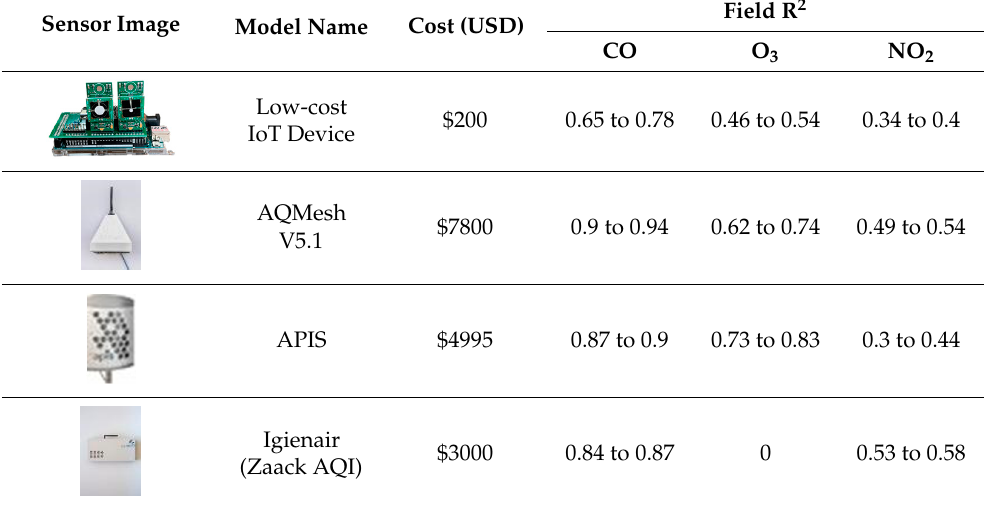
Table 6. Comparison of the sensing performance and equipment cost of the gas sensing equipment of other manufacturers.